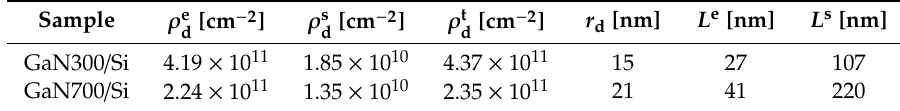
Table 1. Dislocation densities and correlation lengths for GaN in the GaN300 / Si and GaN700 / Si samples. The uncertainty of the presented values is within the least significant digit.